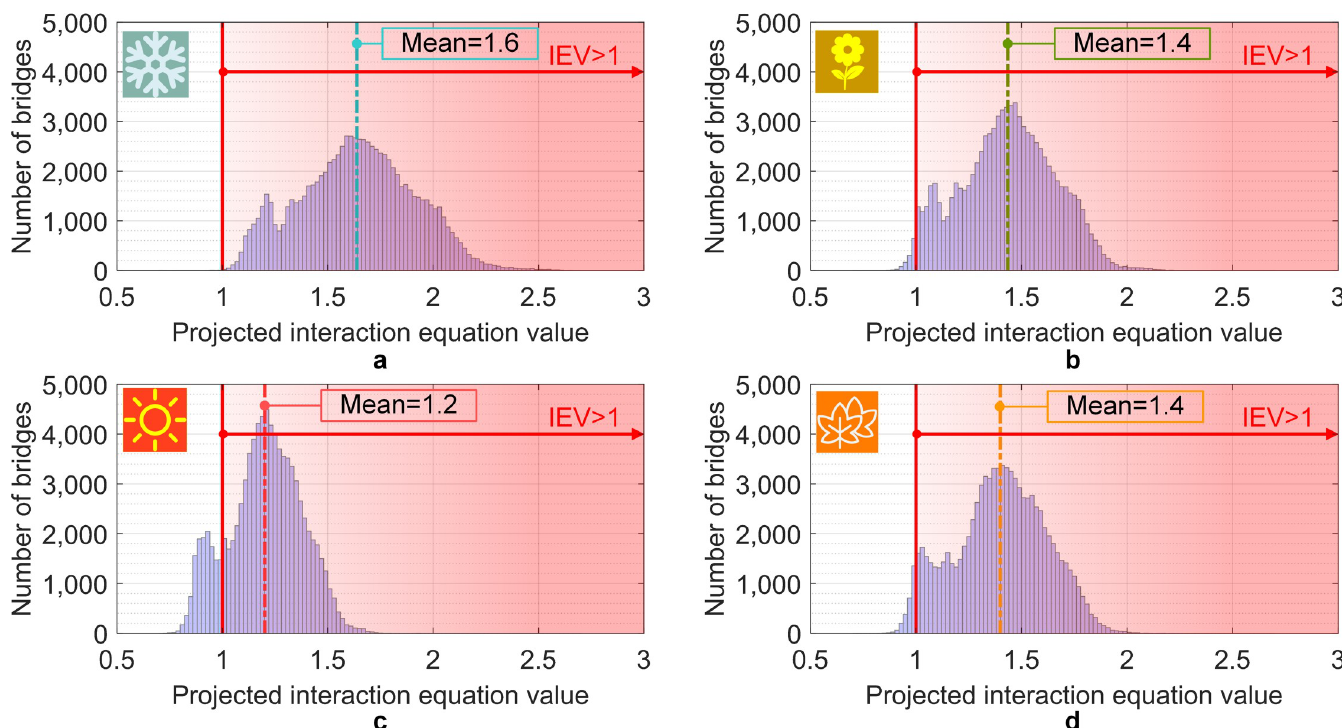
Fig 5. Histograms of the projected interaction equation value (IEV) for temperatures in 2100 under RCP 8.5 considering a) Scenario 1, b) Scenario 2, c) Scenario 3 and d) Scenario 4.